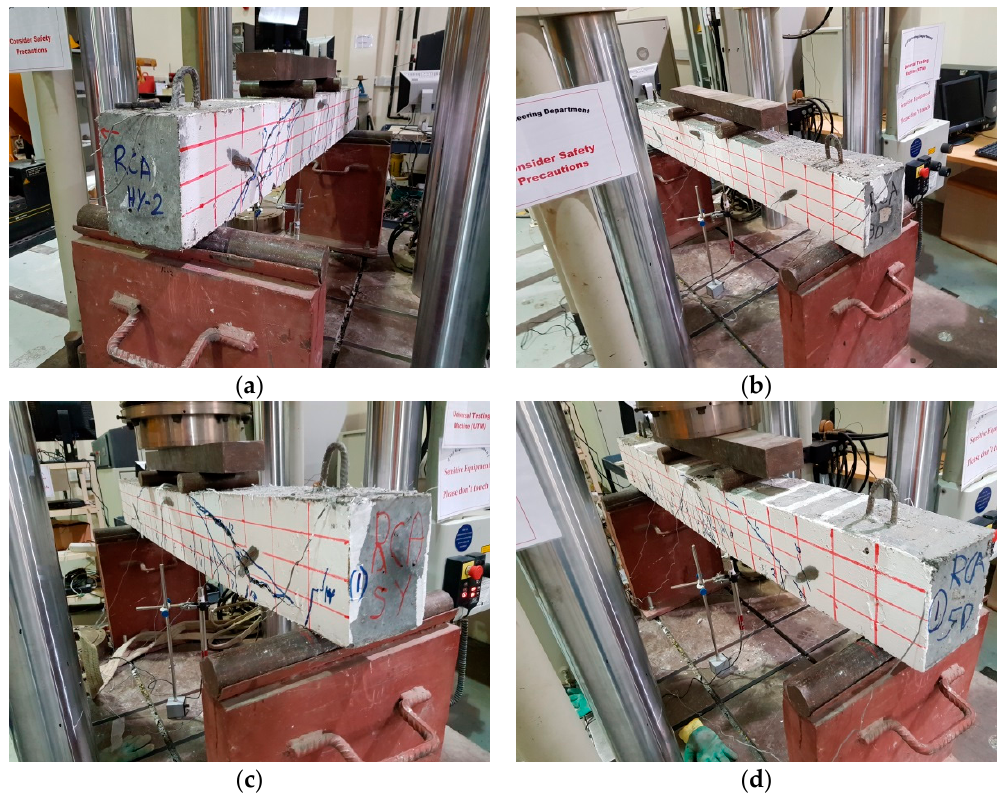
Figure 8. Test setup—beams under loading. ( a ) RCA-HY_1, ( b ) RCA-3D-1, ( c ) RCA-5D-1, ( d ) RCA-SY-1. To enable full-field strain measurements using DIC, a speckle pattern consisting of a white background and black speckles was added to the back surface of each beam. Optical images of the monitored region were collected during loading at a rate of 1 image every 2 s, to failure. All correlations were conducted using a commercial DIC software (Vic-2D 6 from Correlated Solutions, Irmo, SC, USA). Virtual extensometers (VE) were utilized to provide quantitative information about crack openings throughout the loading history. As shown schematically in Figure 9, measurements were made at several locations along the length of major developed cracks. Initially, and prior to crack initiation, the added extensometers exhibit insignificant deformation. However, once a crack initiates and propagates through the monitored region (i.e., passes through the VE), a clear increase in opening values is detected. The opening level increase as the crack propagates reaching significantly larger magnitudes close to